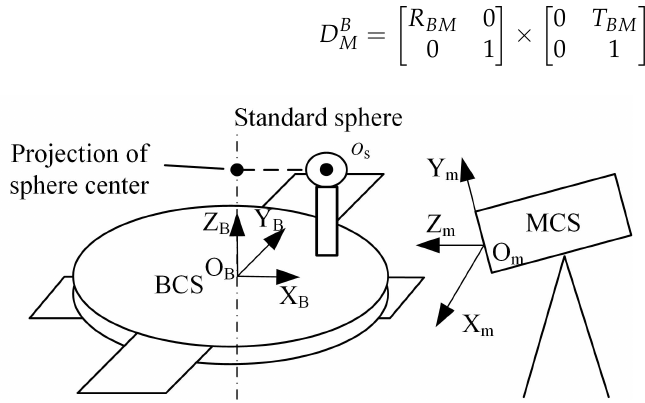
Figure 9. The measurement process of a standard sphere.